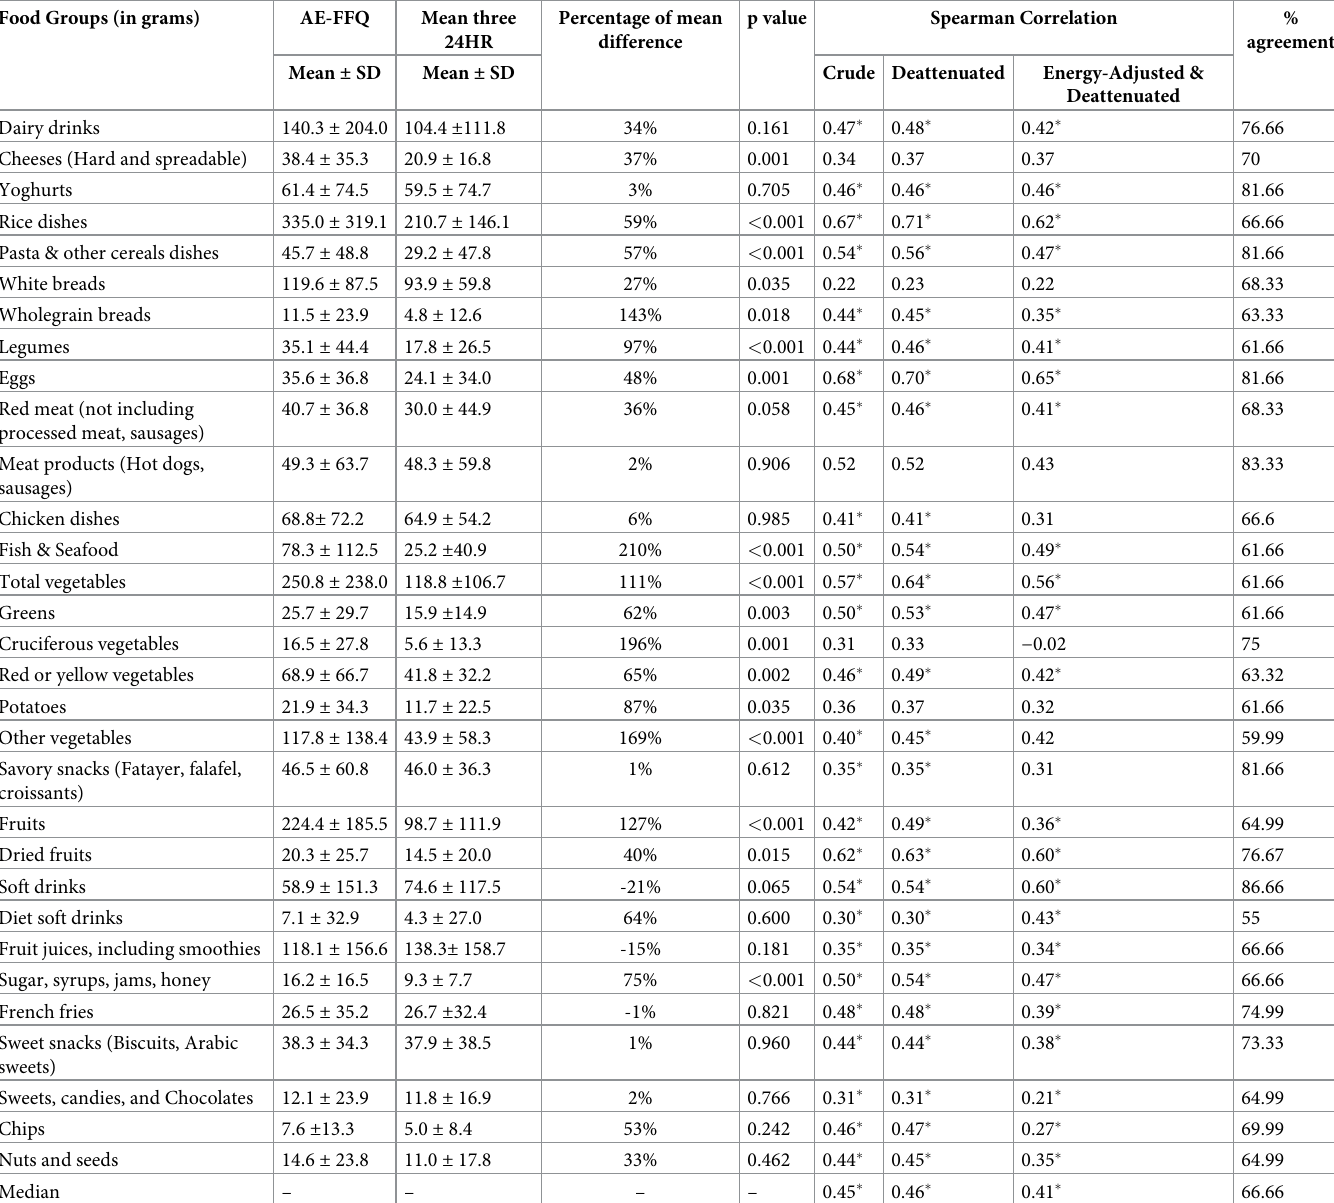
Table 5. Mean daily food groups intakes, Spearman correlation coefficients and % agreement from the average of three 24HRs and the AE-FFQ (n =